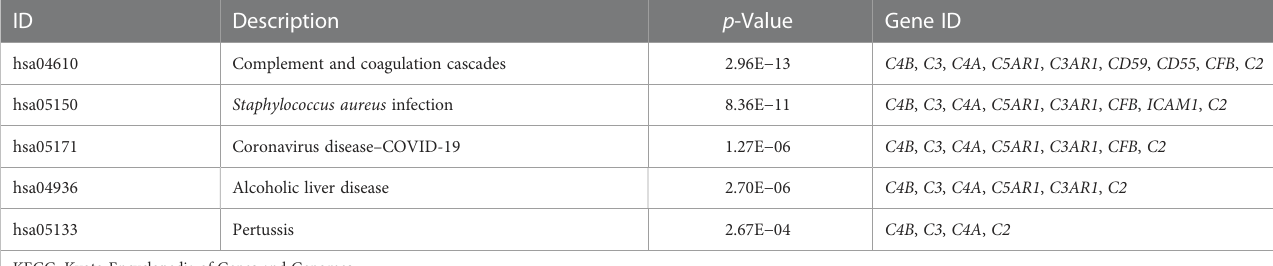
TABLE 3 KEGG pathway enrichment analysis.